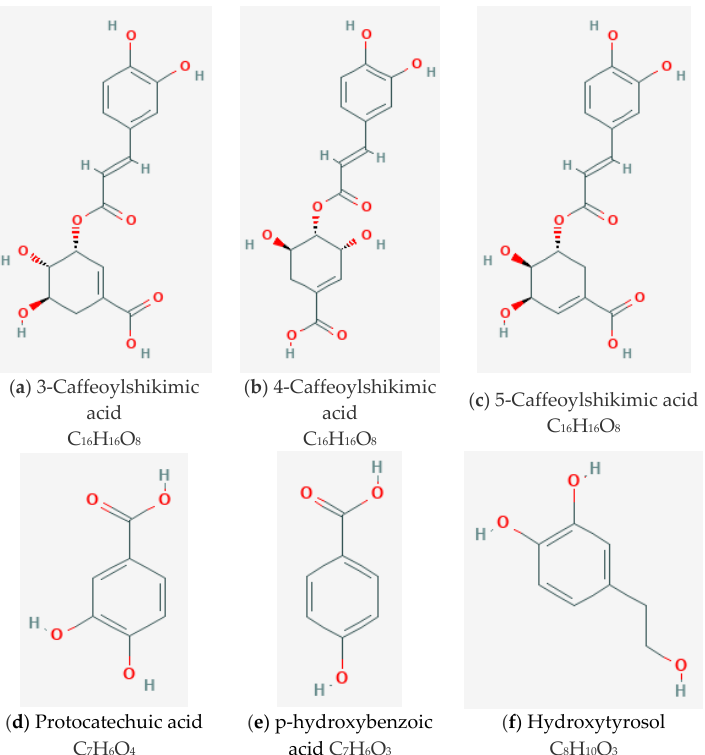
Figure 1. The chemical structures of main components of Oil Palm Phenolics; ( a ) 3-Caffeoylshikimic acid; ( b ) 4-Caffeoylshikimic acid ( c ) 5-Caffeoylshikimic acid; ( d ) Protocatechuic acid (PCA); ( e ) p-